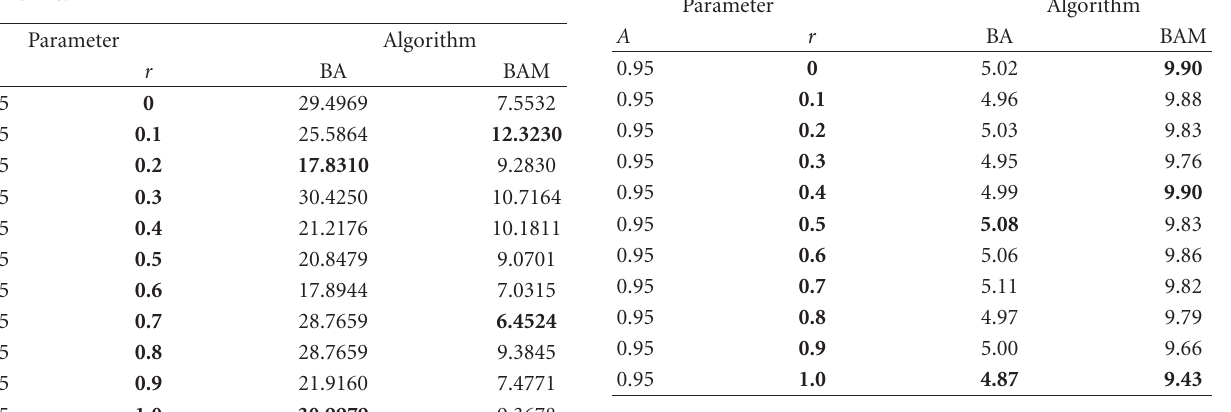
Table 15: Worst normalized optimization results on UCAV path planning problem on di ff erent r . The numbers shown are the worst results found after 100 Monte Carlo simulations of BA and BAM algorithms.